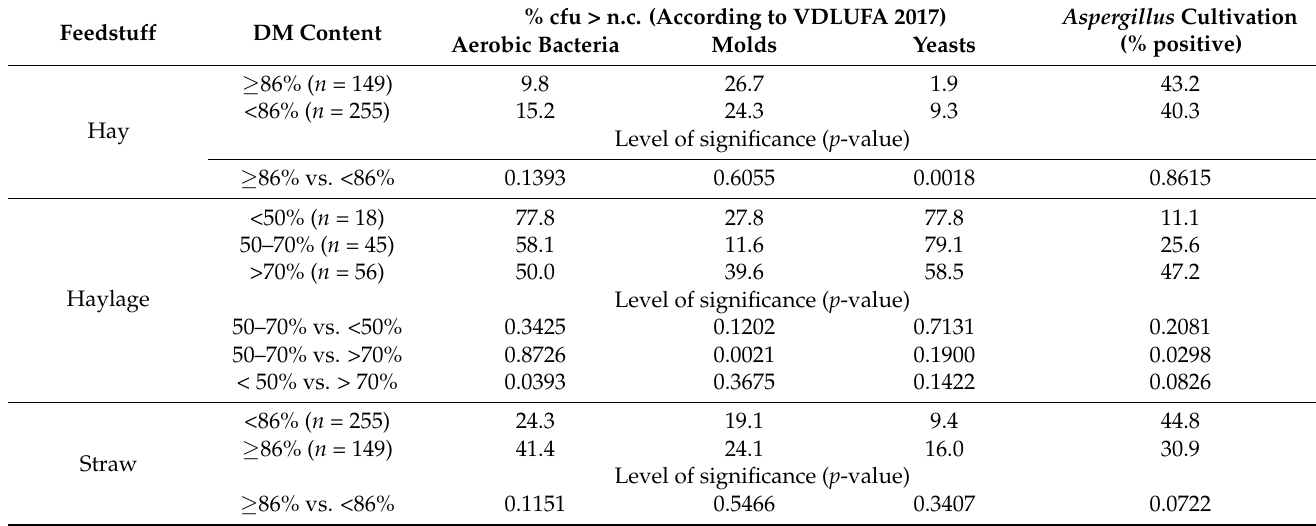
Table 6. Association of deviating dry matter (DM) contents and plate counts exceeding VDLUFA orientation values [51] in hay, haylage, and